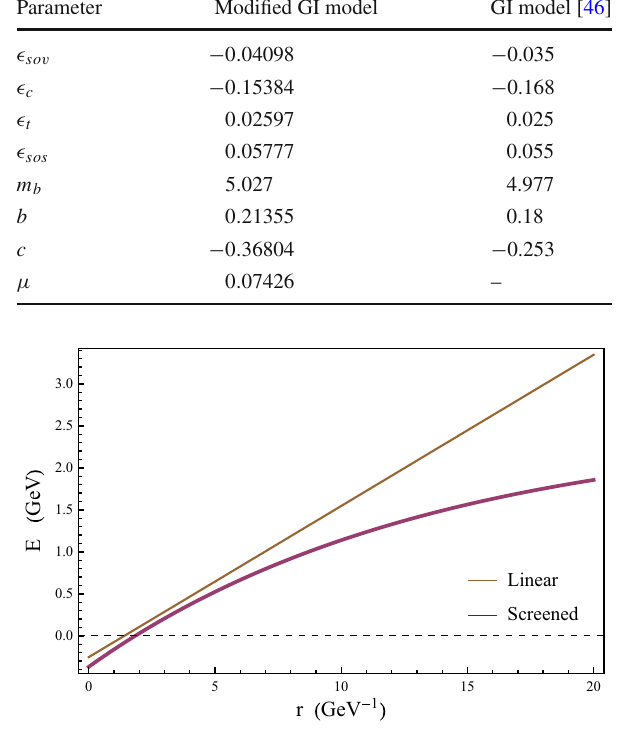
Fig. 1 Comparison of confinement potential curves of the modified GI model with screening effects and the GI model. Our screening effect parameter μ is 0.07426 GeV and other confinement parameters b